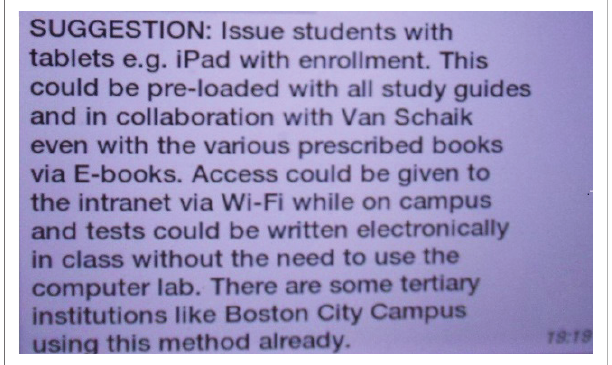
FIGURE 1: Example 1 of student functioning.